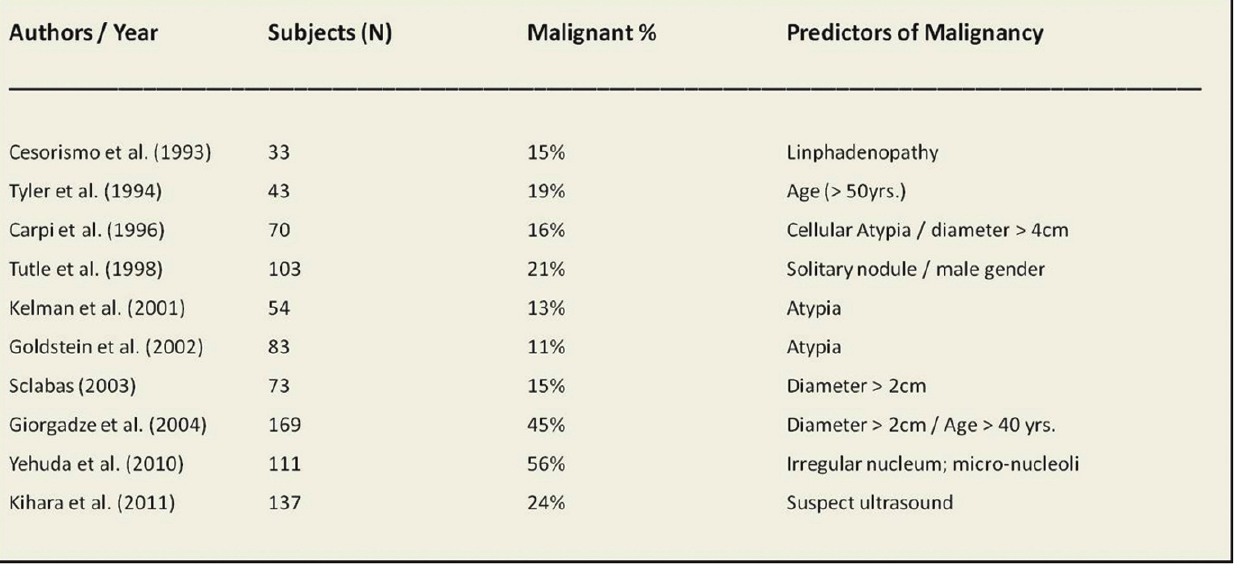
Figure 3 - Malignancy parameters in nodules with indeterminate cytology. Adapted from Banks et al. (50) and Yehuda et